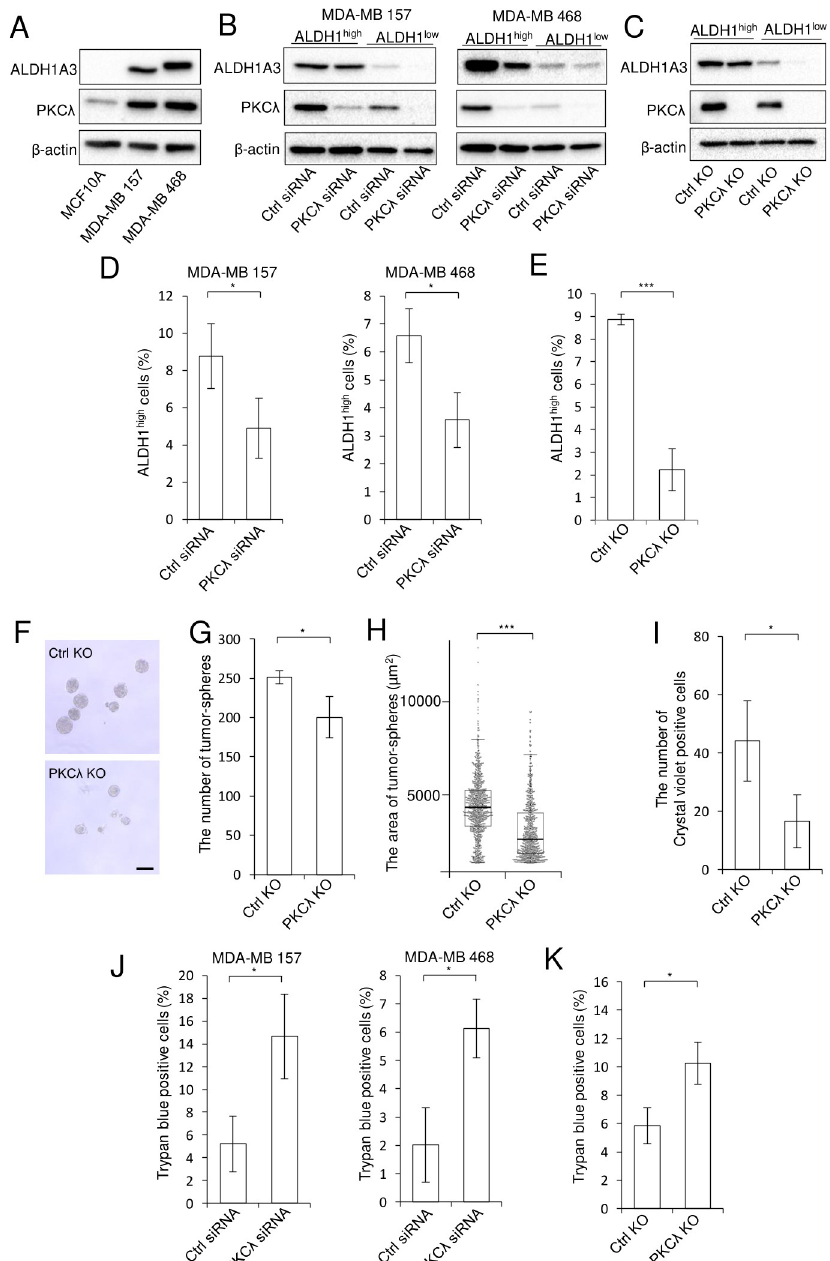
Fig 3. PKC λ depletion reduces in vitro tumor-sphere formation and migration and increases cell death among ALDH1 high cells. (A) Immunoblot analysis of PKC λ and ALDH1A3 expression in MCF10A, MDA-MB 157 and MDA-MB 468 cells. (B) Immunoblot analysis of PKC λ and ALDH1A3 expression in ALDH1 high and ALDH1 low cells isolated after PKC λ KD using targeted siRNA in MDA-MB 157 (left) and MDA-MB 468 (right) cells. (C) Immunoblot analysis of PKC λ and ALDH1A3 in ALDH1 high and ALDH1 low cells isolated from control or MDA-MB 157 PKC λ KO cells. In panels A-C, β -actin was used as an internal control. (D) ALDEFLUOR assays of the numbers of ALDH1 high cells isolated from among MDA-MB 157 (left) and MDA-MB 468 (right) cells after PKC λ KD using targeted siRNA. � p < 0.05, Student’s t-test. (E) ALDEFLUOR assays of the numbers of ALDH1 high cells isolated from among control or MDA-MB 157 PKC λ KO cells. � p < 0.05, ��� p < 0.001, Student’s t-test. (F-H) in vitro tumor-sphere formation by ALDH1 high control or MDA-MB 157 PKC λ KO cells. Shown are representative images (F), numbers of tumor-spheres, � p < 0.05, Student’s t-test (G), and areas of the tumor-spheres, ��� p < 0.001, two-sided Mann-Whitney’s U test (H). Scale bar, 50 μ m. (I) Transwell migration of ALDH1 high control or MDA-MB 157 PKC λ KO cells. Cells that migrated to the lower side of the insert filter were stained with crystal violet and counted. � p < 0.05, Student’s t-test. (J) Trypan blue assays of ALDH1 high MDA-MB 157 (left) and MDA-MB 468 (right) cells performed 72 h after PKC λ siRNA